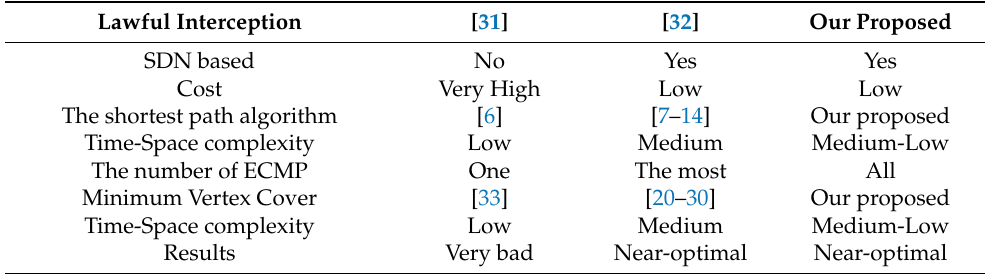
Table 1. Comparisons of related